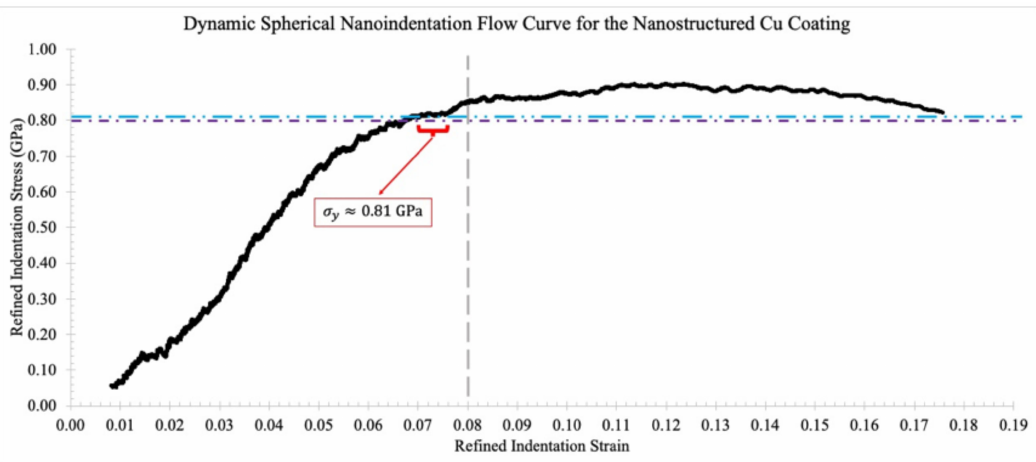
Figure 30. The spherical dynamic stress–strain curve of the nanostructured Cu cold spray coating with the strain associated with hardness testing and Tabor’s relation (in gray), the σ y from analysis of the flow curve (captured in the red box), the σ y of a similarly nanostructured pure Cu with a grain size of about 20 nm (in purple) and the Hall–Petch-obtained σ y (in blue).